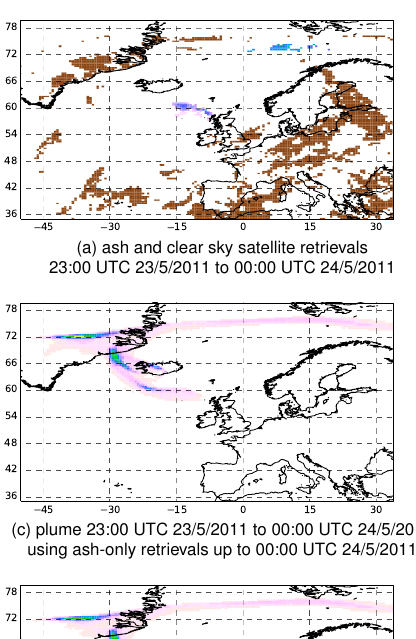
Run Date: February 28, 2018